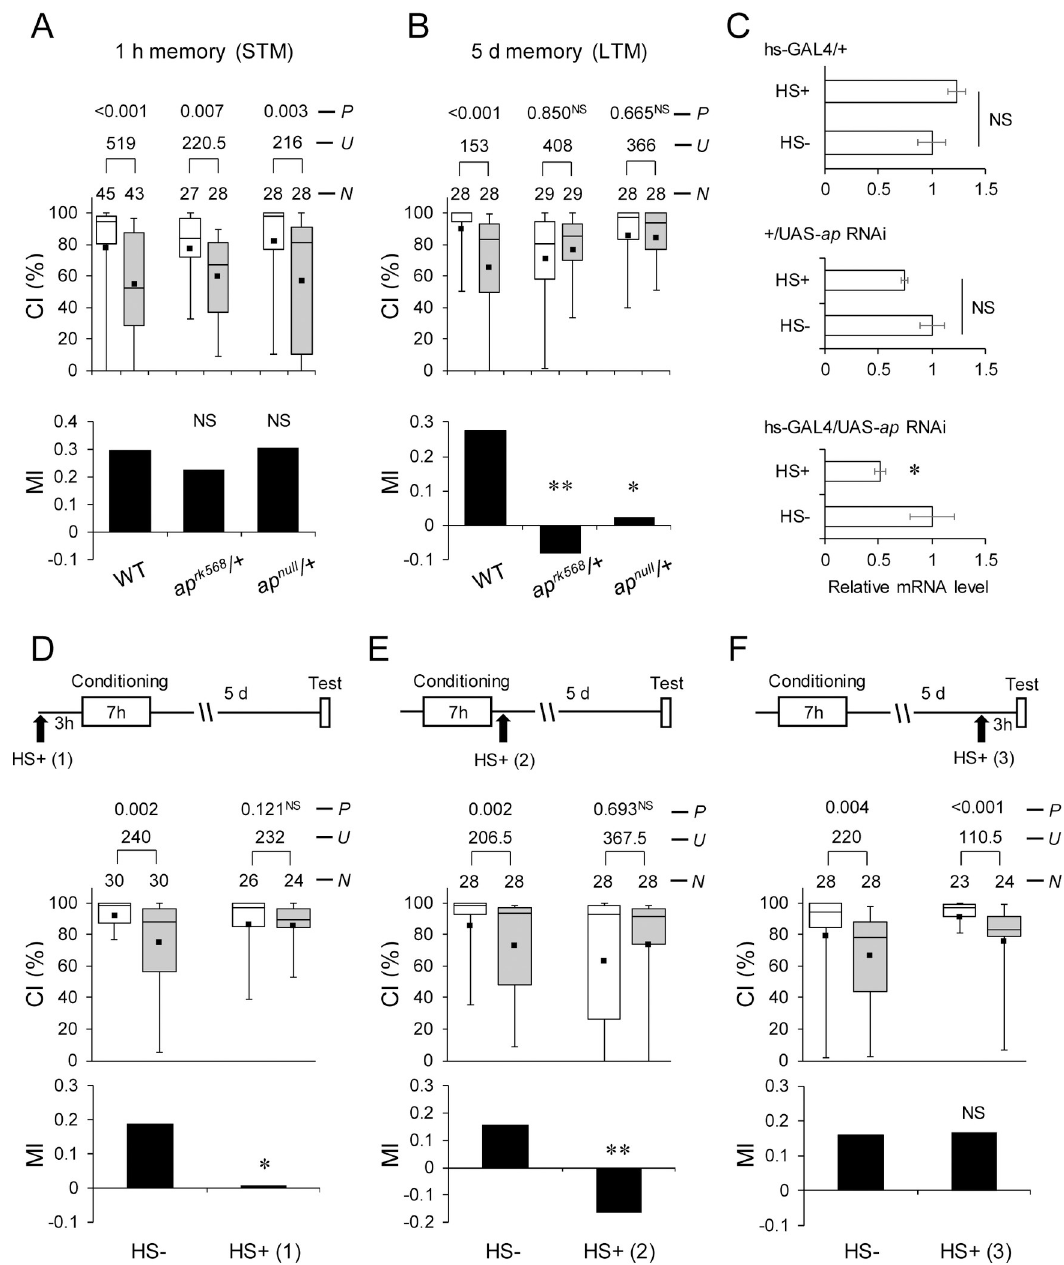
Fig 1. Ap is necessary for LTM. The underlying data can be found in S1 Data. (A) WT, ap rk568 /+, and ap null /+ flies were used in the experiments. Males were tested for 1 hour after 1-hour conditioning (1-hour memory). (B) WT, ap rk568 /+, and ap null /+ flies were used in the experiments. Males were tested on day 5 after 7-hour conditioning (5-day memory). (C) Real-time qRT-PCR analysis of ap mRNA expression level. hs-GAL4 was used for the induction of ap RNAi. Mean ± SEM was calculated from 5 to 6 replicates. HS − , non–heat-shocked flies. HS+, flies with heat-shock treatment (20 minutes) 3 hours before RNA extraction. � , P < 0.05; NS, not significant. Error bars show SEM in each figure. (D) Five-day memory after 7-hour conditioning in flies with or without a 20-minute heat-shock treatment 3 hours before conditioning [HS+ (1)]. (E) Five-day memory after 7-hour conditioning. HS+ (2), flies with heat-shock treatment immediately after conditioning. (F) Five-day memory after 7-hour conditioning. HS+ (3), flies with heat-shock treatment 3 hours before test. (A, B, and D–F) Box plots for a set of CI data show fifth, 25th, 75th, and 95th centiles. In the box plots, the black square in each box indicates the mean, the line in each box is drawn at the median, the white boxes indicate naive males, and the gray boxes indicate conditioned males. CI, courtship index; MI, memory index; N , sample size; U , Mann–Whitney U ; P , probability; � , P < 0.05; �� , P < 0.01; NS, not significant. (D–F), hs-GAL4/UAS- ap RNAi flies were used. Ap, Apterous; LTM, long- term memory; qRT-PCR, quantitative reverse transcription PCR; RNAi, RNA interference; WT, wild-type.